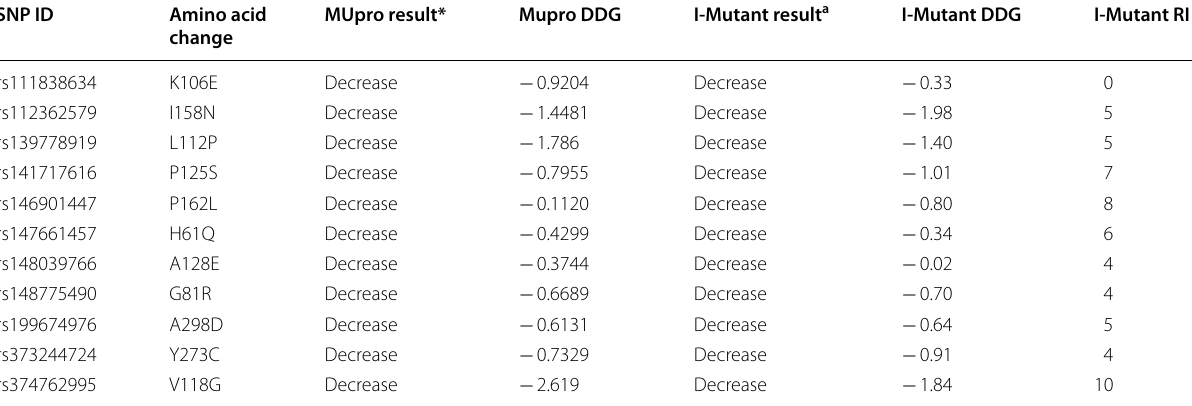
a Protein stability: Increase or decrease; DDG values are calculated in